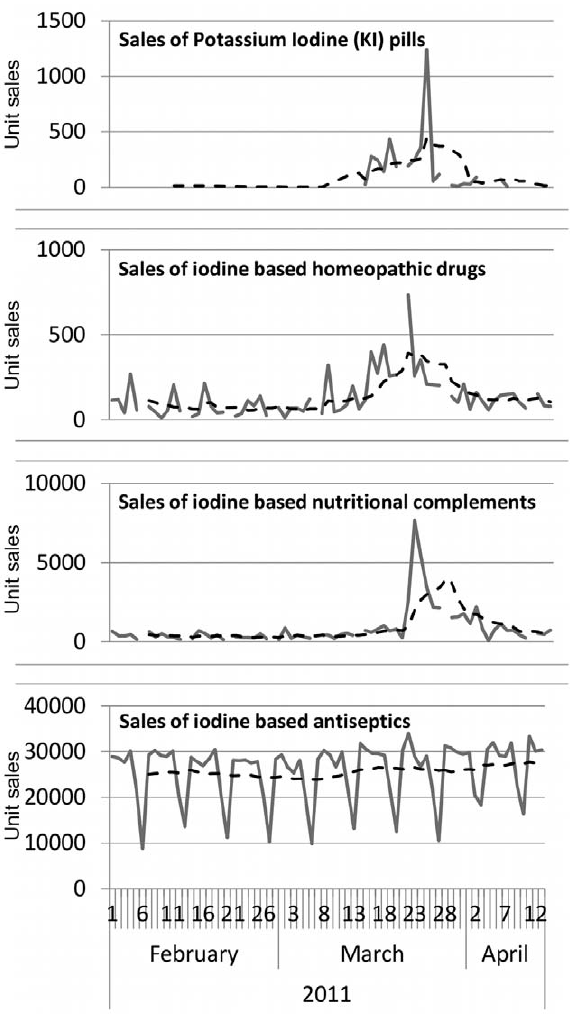
Figure 1. Sales of iodine based products (per units) in French pharmacies between February and April 2011. Dashed lines show the weekly sliding average.